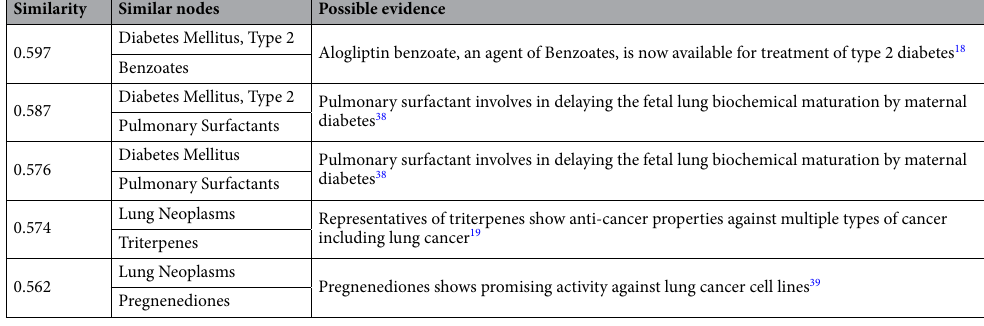
Table 3. Similar condition nodes and drug-term nodes for drug repurposing. The average cosine similarity between condition nodes and drug-term nodes is -